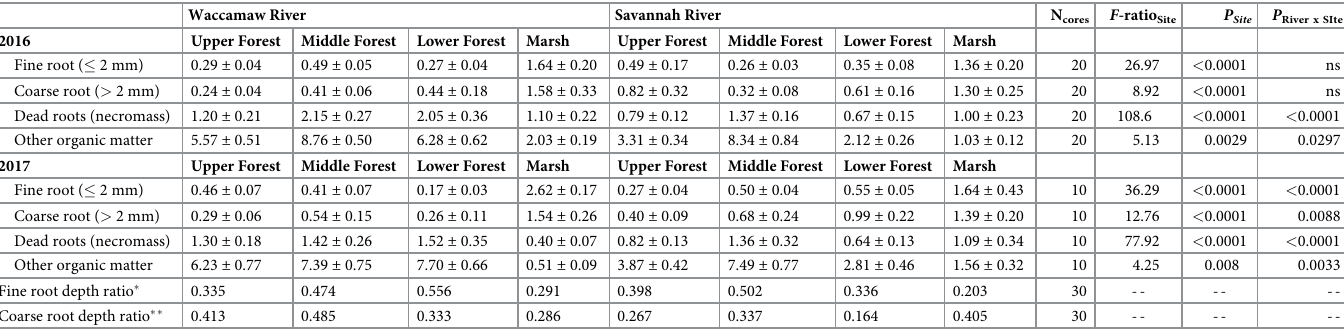
Table 2. Characteristics of the root zone to a depth of 30-cm in 2016 and 2017.